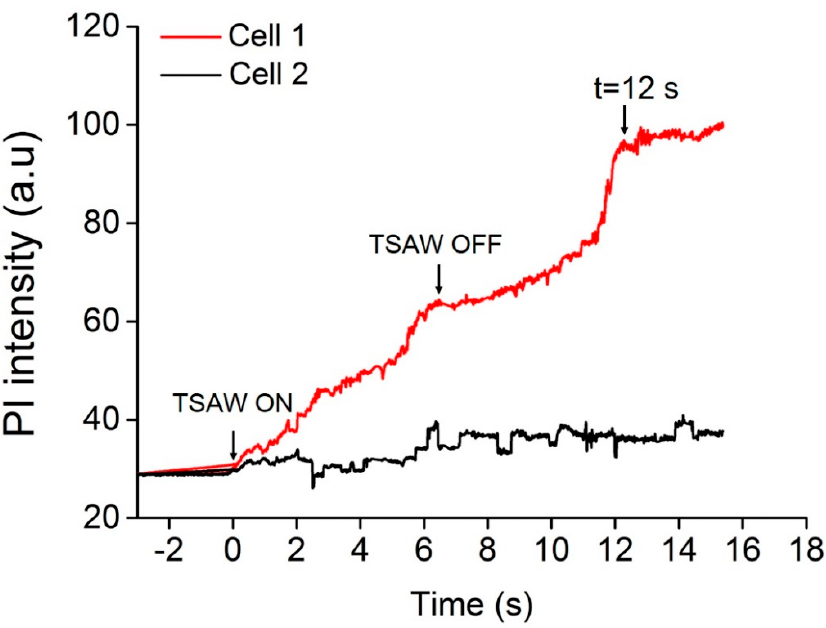
Figure 3. The curve of PI fluorescence intensity for cells with time. Before and after TSAW excitation, the increase in the rate of PI fluorescence intensity was different and the recovery time of a cell membrane pore might be 12 s.